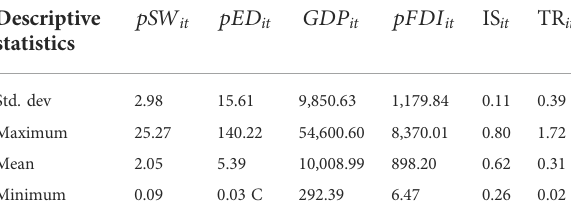
TABLE 4 Summary statistics, panel (before taking the logarithm), 2001 – 2017. Descriptive